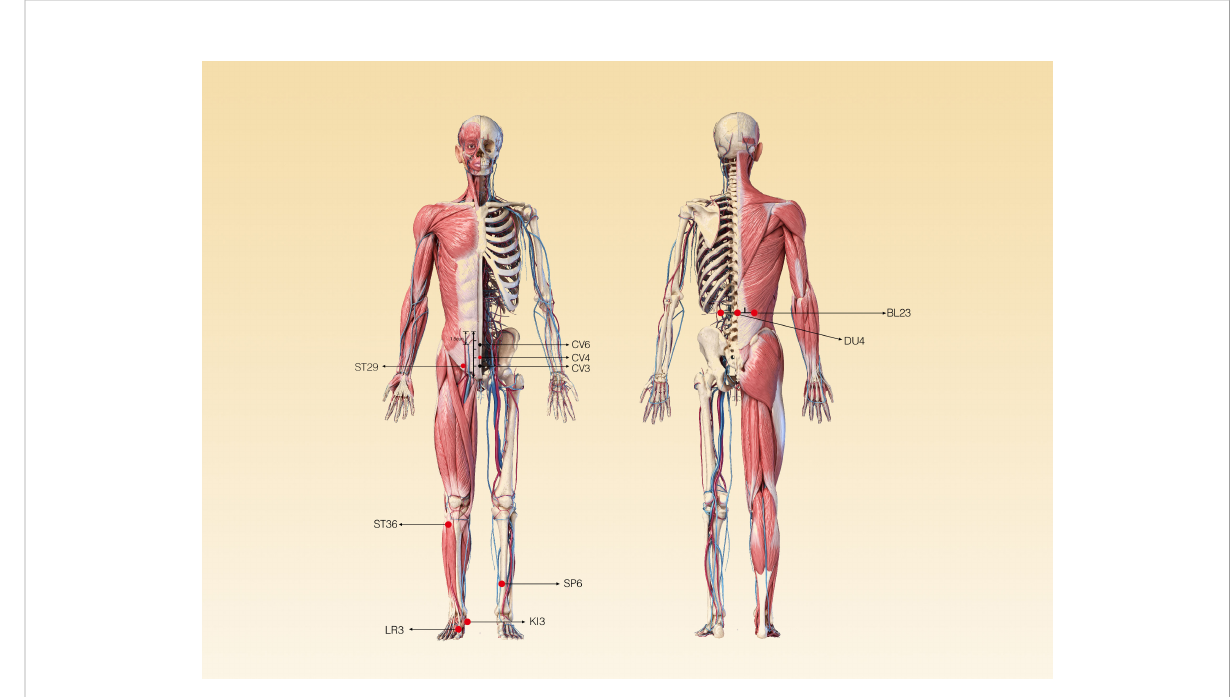
FIGURE 2 The location of the acupoints for the treatment of male infertility.